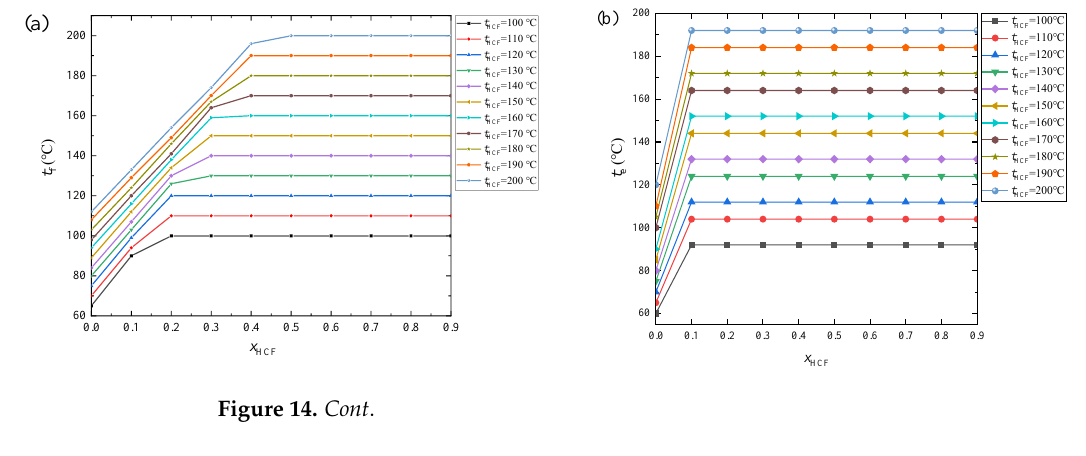
and ( c ) SFORC system.